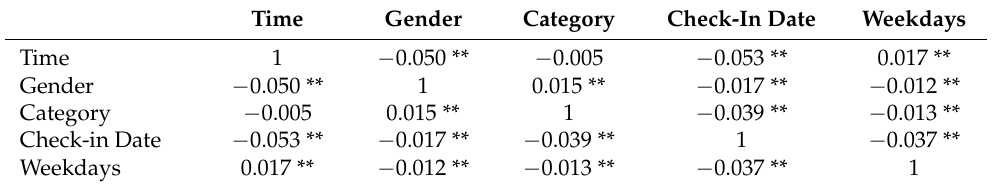
Table 2. Correlations